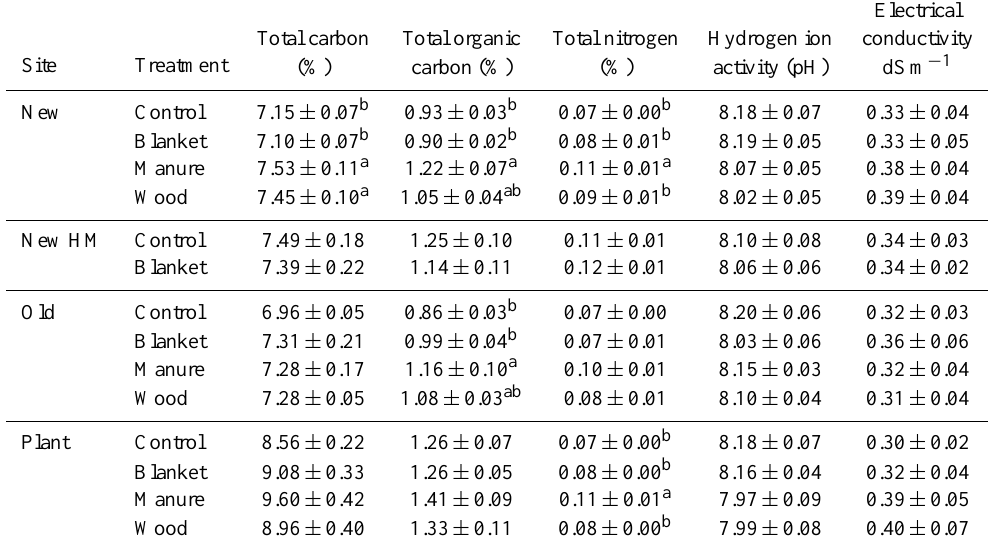
Values are mean ± standard error. Values of ± 0.00 in the table were < 0.006. Letters indicate statistically significant differences among treatments in a site. Absence of letters indicates no statistical